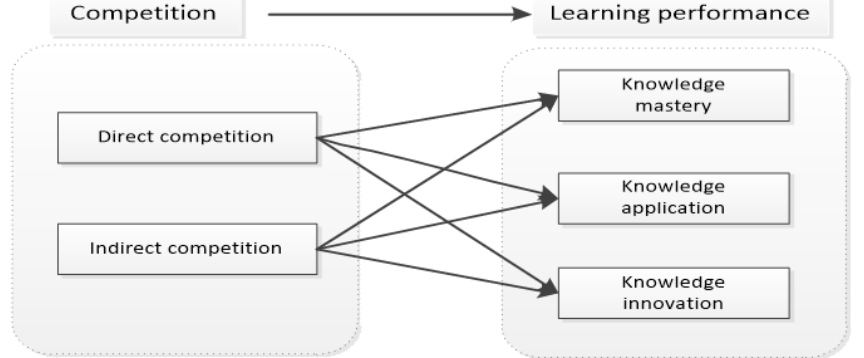
Figure 1. Mechanism model of competition’s impact on learning performance.